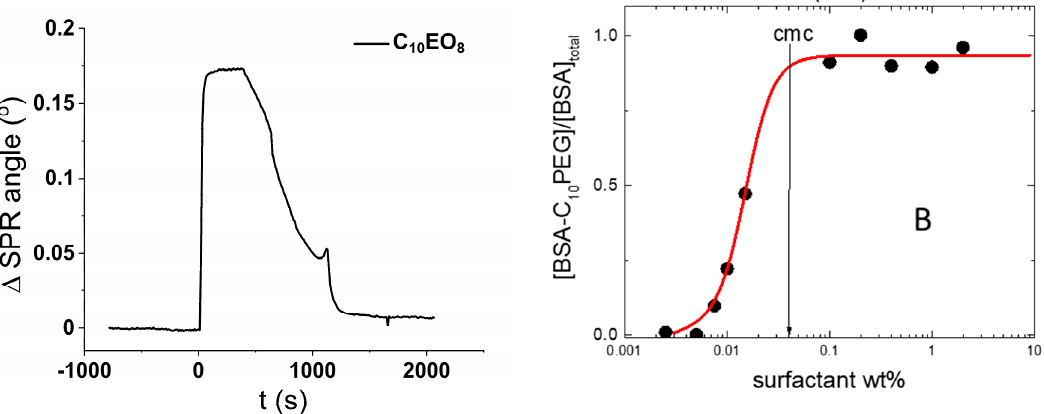
Figure 4. ( A ) SPR sensogram of the interaction of C 10 PEG with a SiO 2 surface and ( B ) fraction of protein bound to surfactant in solution versus surfactant concentration calculated from fluorescence experiments as reported by Mateos et al. [17].